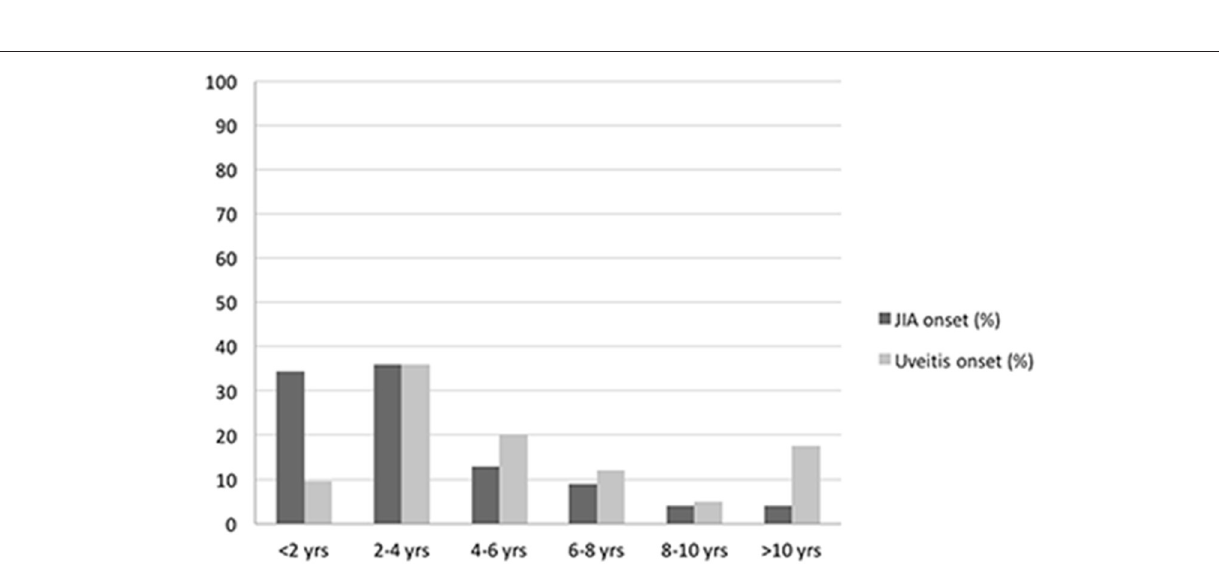
keratopathy, posterior synechiae, cataract, glaucoma, macular edema and other posterior pole abnormalities were